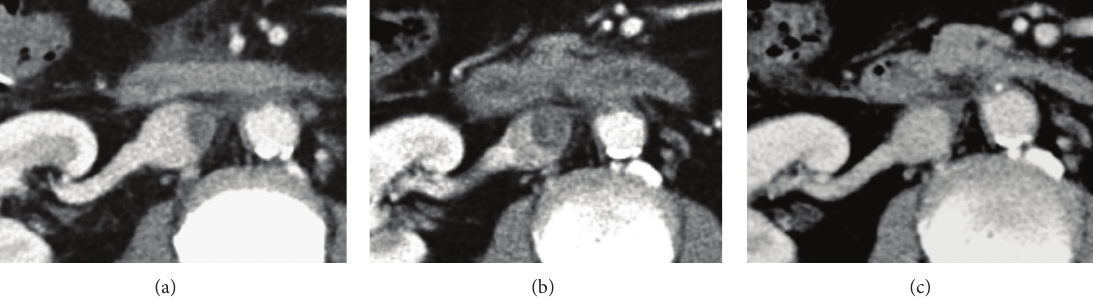
Figure 1: Contrast-enhanced abdominal computed tomography. (a) Mural thrombus extensively adhered to the vessel wall in the infrarenal inferior vena cava (IVC). (b) Anticoagulant therapy with unfractionated heparin and antithrombin was administered, but the IVC thrombus continued to increase in size, five days later. (c) After switching to warfarin and fondaparinux sodium anticoagulant therapy, the IVC thrombosis significantly shrank within one month.